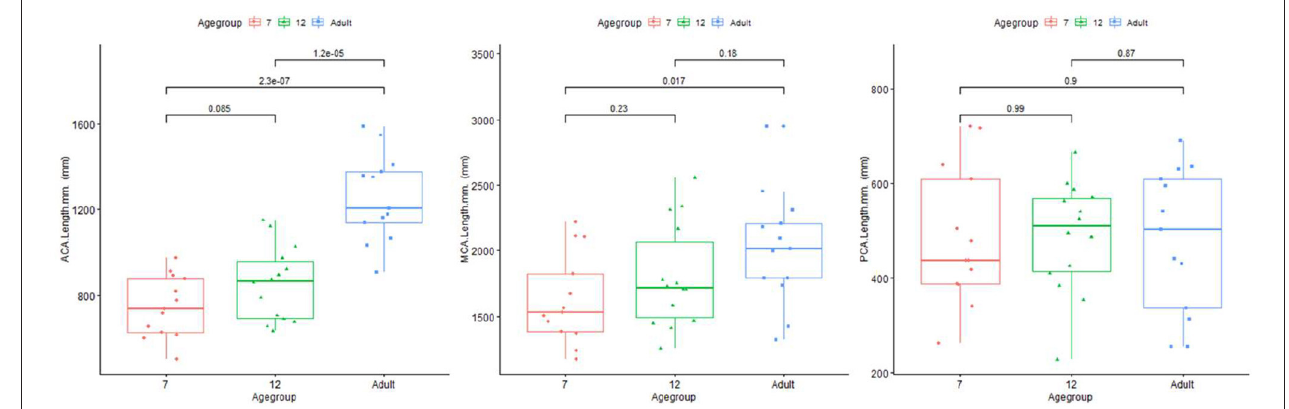
FIGURE 8 | Plot for length of ACA (left), MCA (middle), and PCA (right) regions of infants and adults.